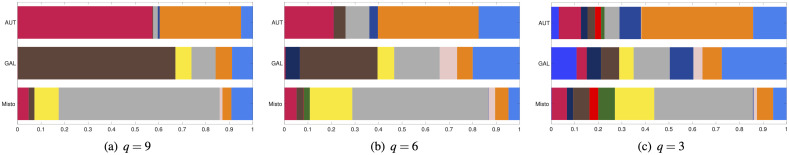
Segmentation plot of the mean DNA of senators belonging to the groups “Misto”, “GAL” and “AUT” for different values of q and c = 160 (corresponding to non-sparse PCA).